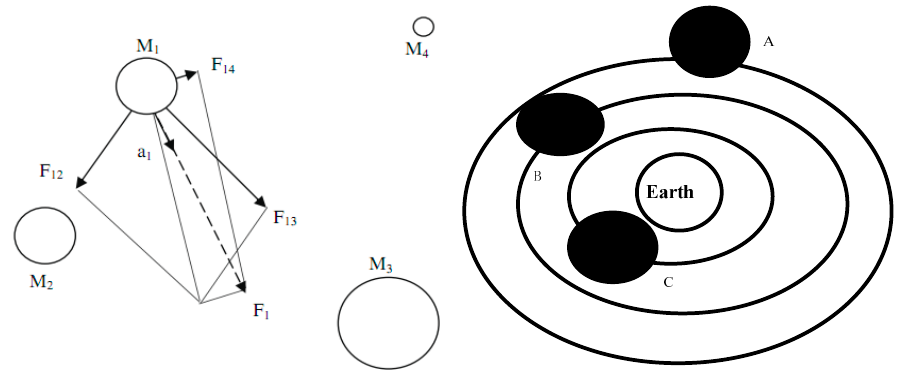
Figure 1. Gravitational phenomena.